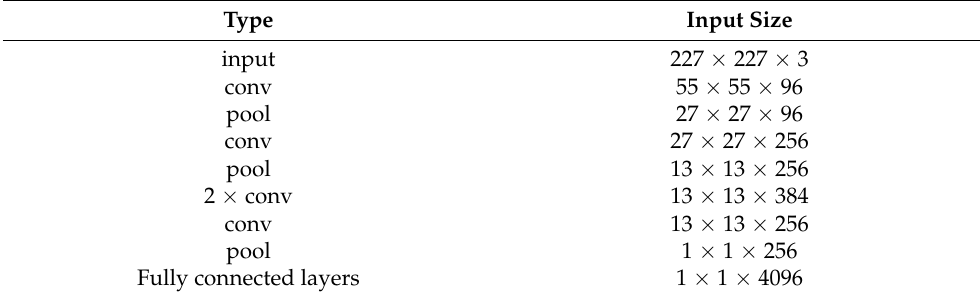
Figure 2. AlexNet architecture. FC layers are depicted as a green cube, as they represent the classification algorithm that will be used. Table 1. Summary of the AlexNet architecture in terms of input size requirements for every layer of the network.